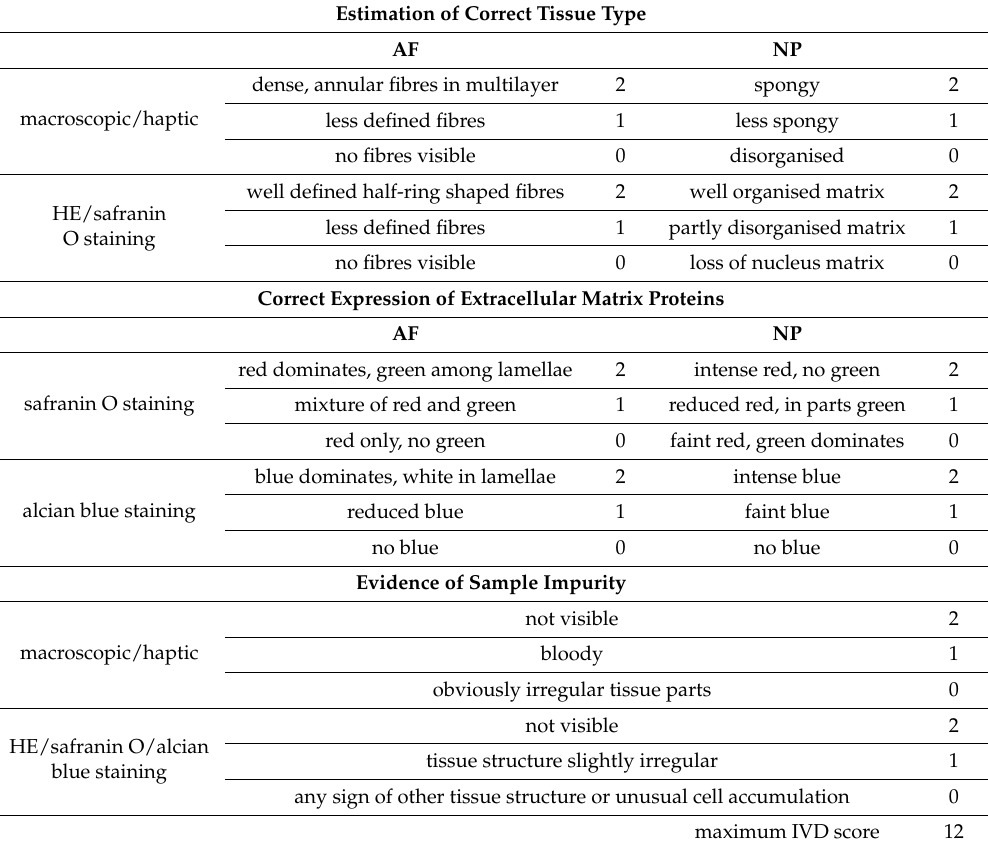
Table 1. IVD score to assess the character of either AF or NP tissue of small-sized